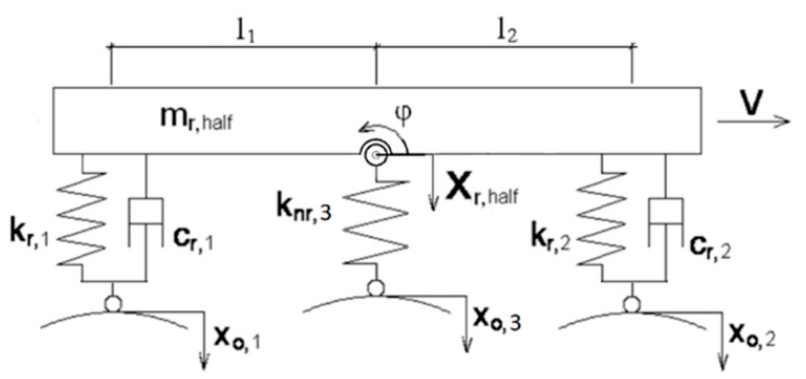
Figure 3. Half model of a vehicle.